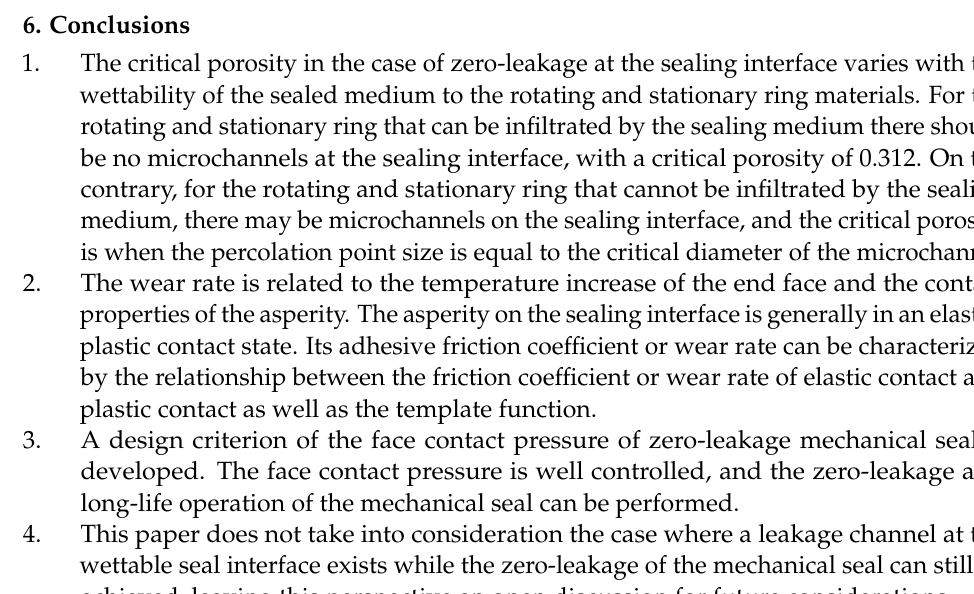
Figure 7. Influence of the medium temperature on the face contact pressure range.